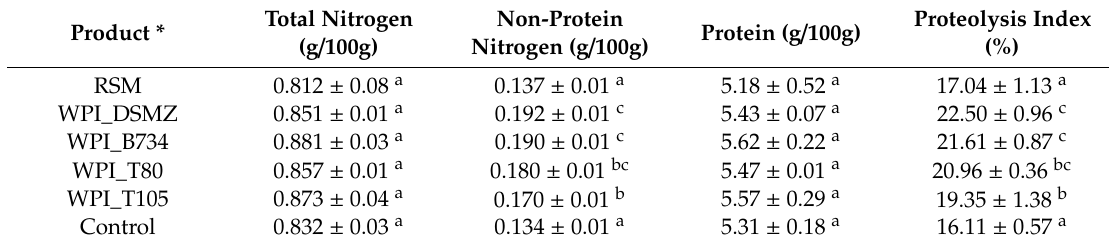
Table 2. Comparison of the content of protein, total nitrogen, and non-protein nitrogen, and the proteolysis index in the analyzed